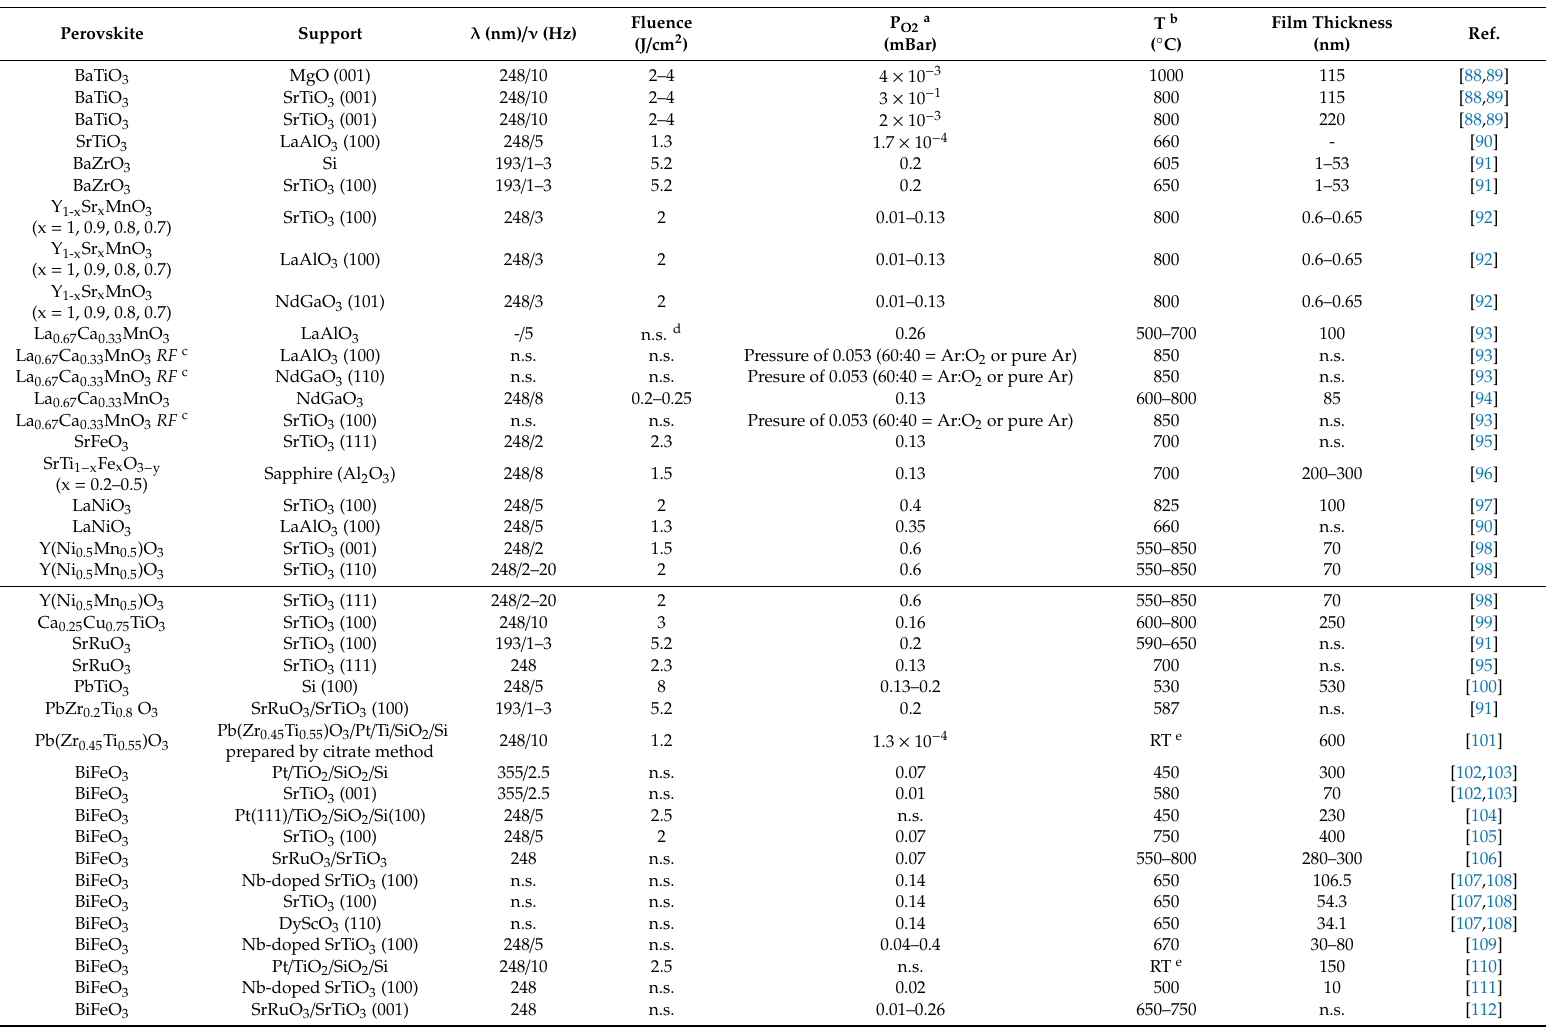
Table 6. Experimental conditions for di ff erent types of perovskite materials grown by PLD and PLD-RF techniques and the thickness of the films